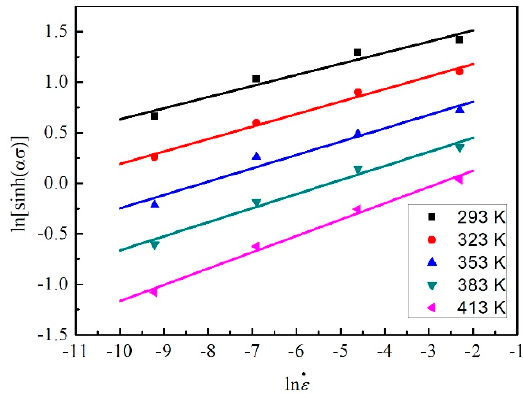
. ε at the strain of